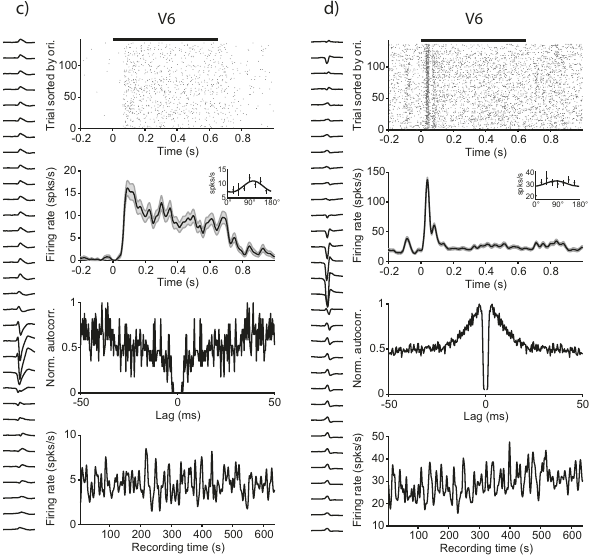
period (0 – 0.65s). Error bars and shaded areas indicate SEM. Third row: peak- normalized auto-correlogram for all spikes across the recording. Bottom row: smoothed fi ringrate(Gaussianwindow, σ =2s)acrosstheentiresession,indicating the stability of the recordings. The fi rst and last 5seconds of data were excluded due to artifacts arising from the connection or disconnection of the recording system. All examples from one recording session in Monkey A. Source data are provided as a Source Data fi